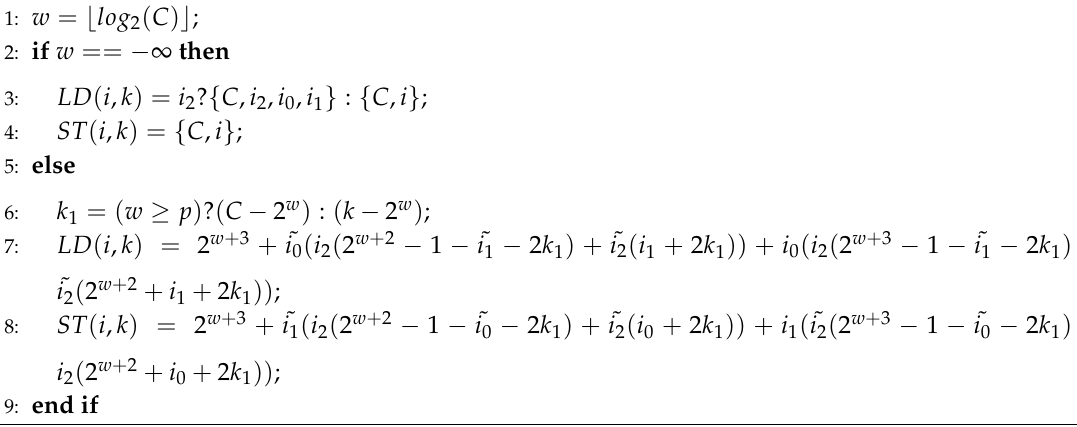
Algorithm 2 Load and store scheme of the ( n − 1 ) th